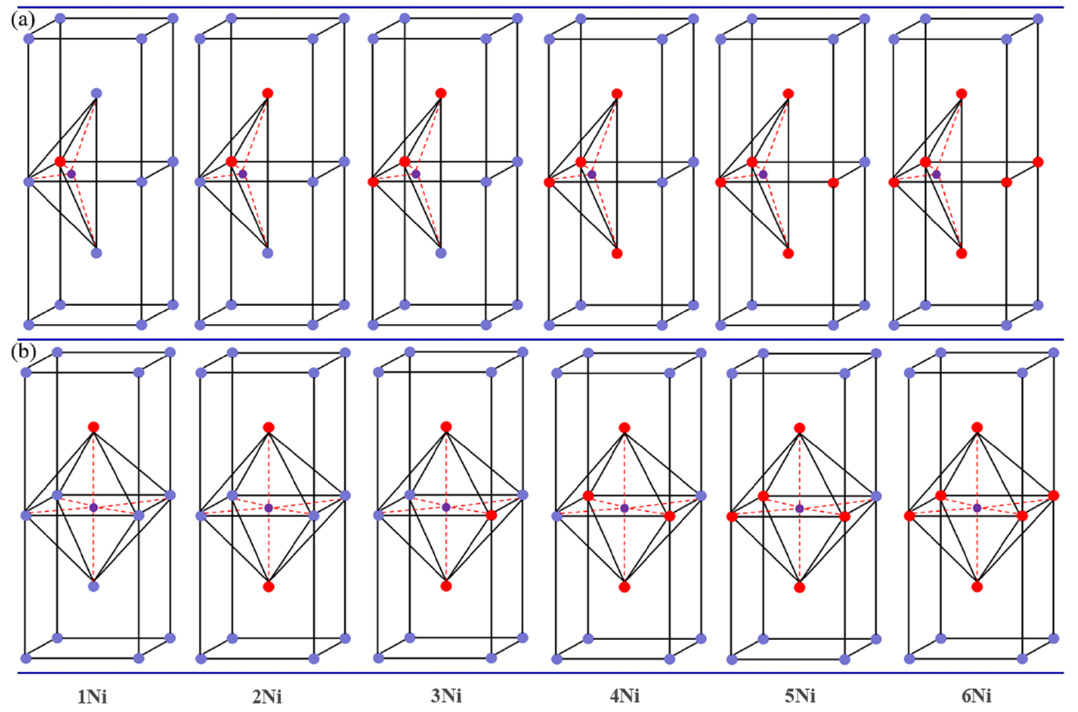
Figure 3. Models showing addition of different numbers of Ni atoms in ( a ) TISs and ( b ) OISs.